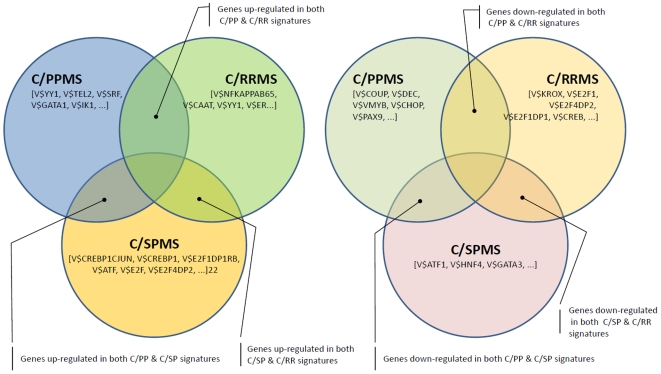
The A) up- and B) down-regulated signature subsets.(Note that when two groups were combined, the genes in the intersection are also included in the analysis). The most significant transcription factor motifs associated with a group are shown in square brackets.